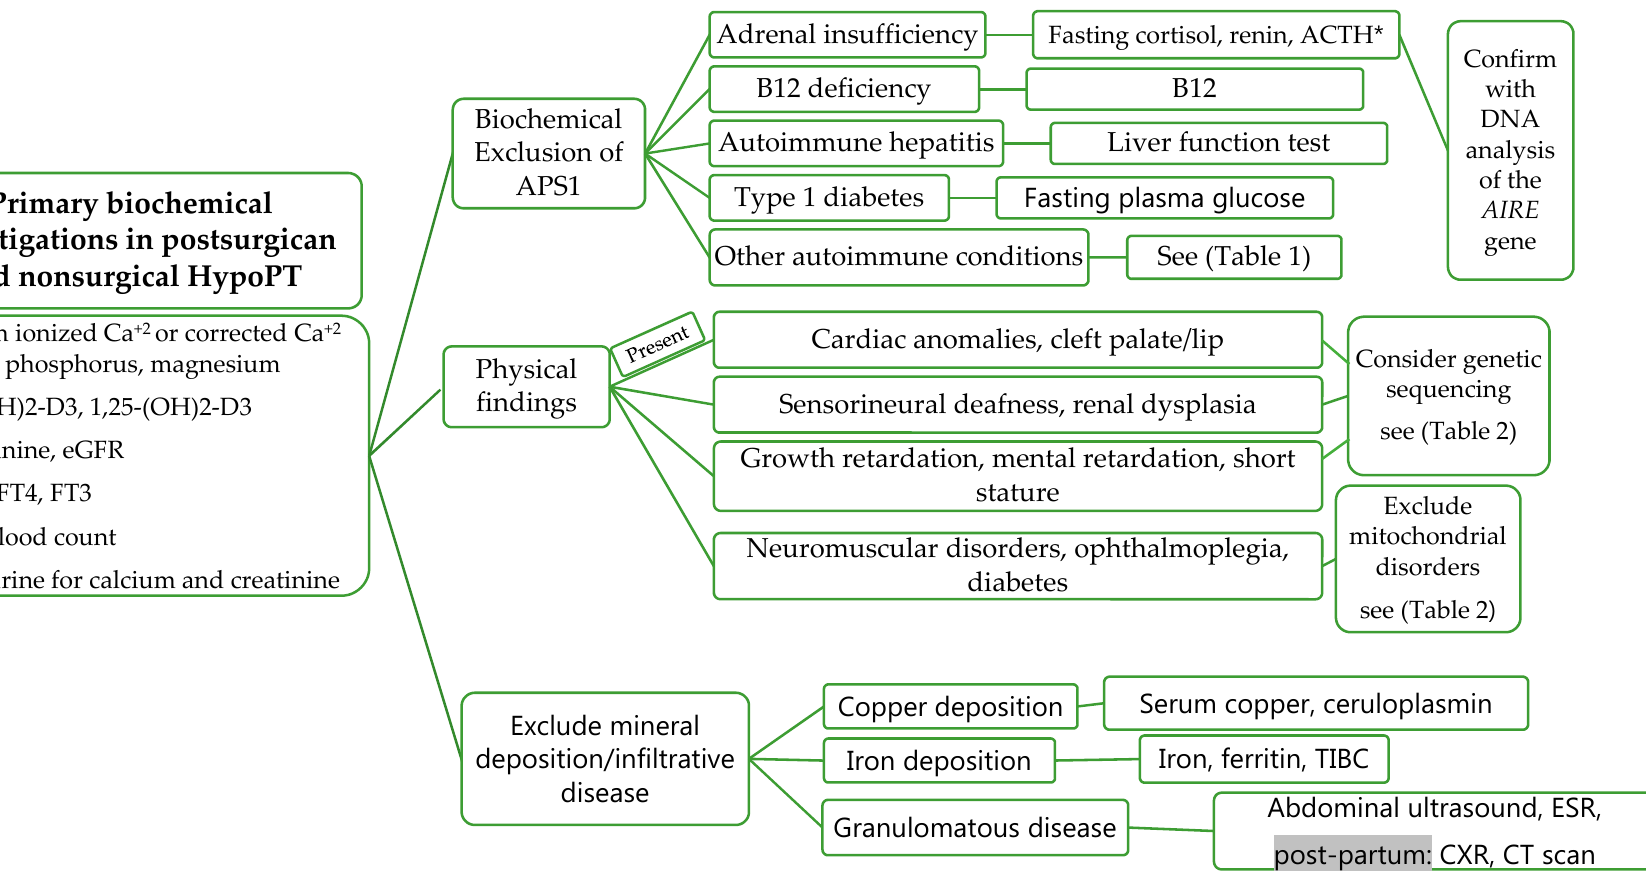
Figure 4. Evaluation and Investigations of HypoPT. Abbreviations: APS1, autoimmune polyendocrine syndrome; TIBC, total iron-binding capacity; Ca +2 , calcium; eGFR, estimated glomerular filtration rate; ACTH, adrenocorticotropic hormone; CXR, chest X-ray; AIRE, autoimmune regulator of endocrine function; * please note, levels are altered during pregnancy, grey background, post-partum investigations.